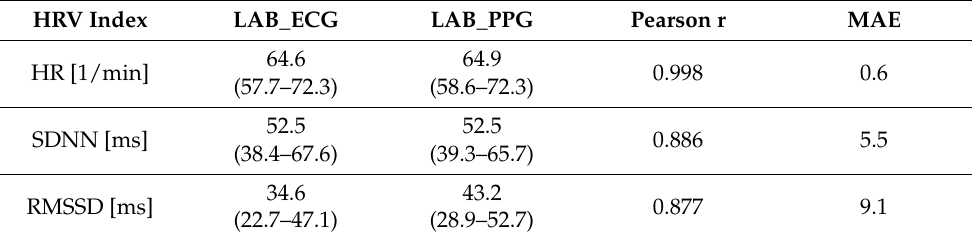
Table 2. Comparison of HRV derived from ECG and PPG recorded in the laboratory (N = 55).